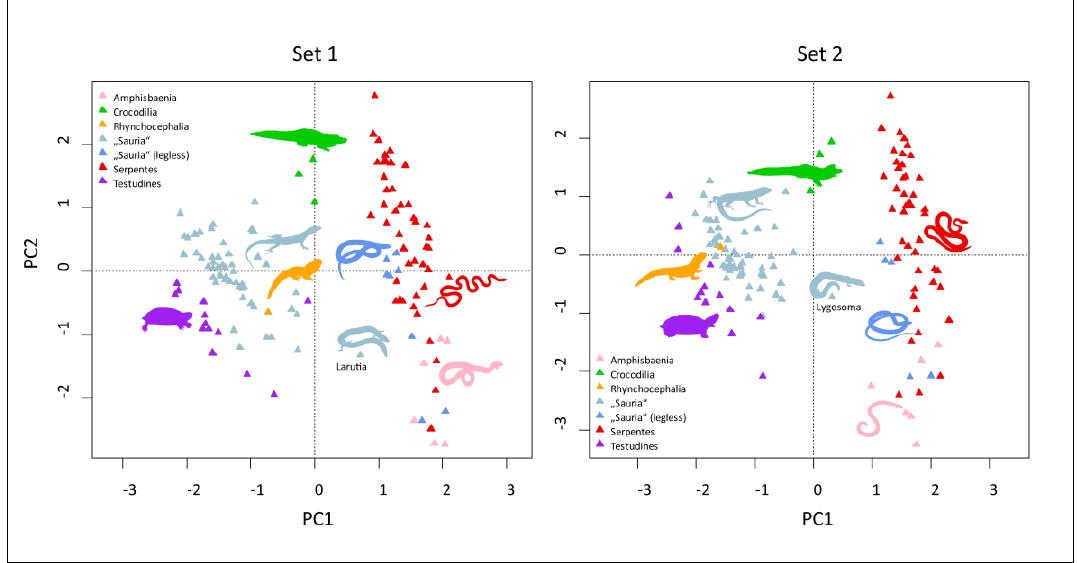
Figure 2. Plotting the species scores onto PC1 and PC2 axes, for Set 1 and Set 2 separately.